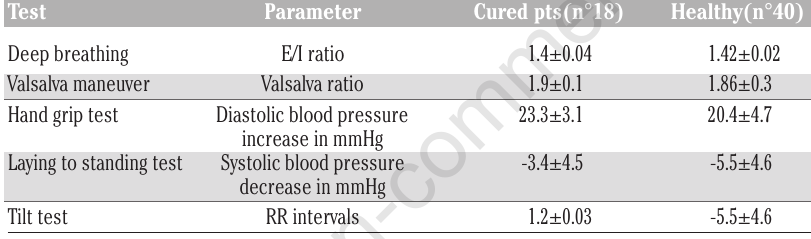
Table 4. Results of autonomic tests in the study group (Cured vs. Healthy